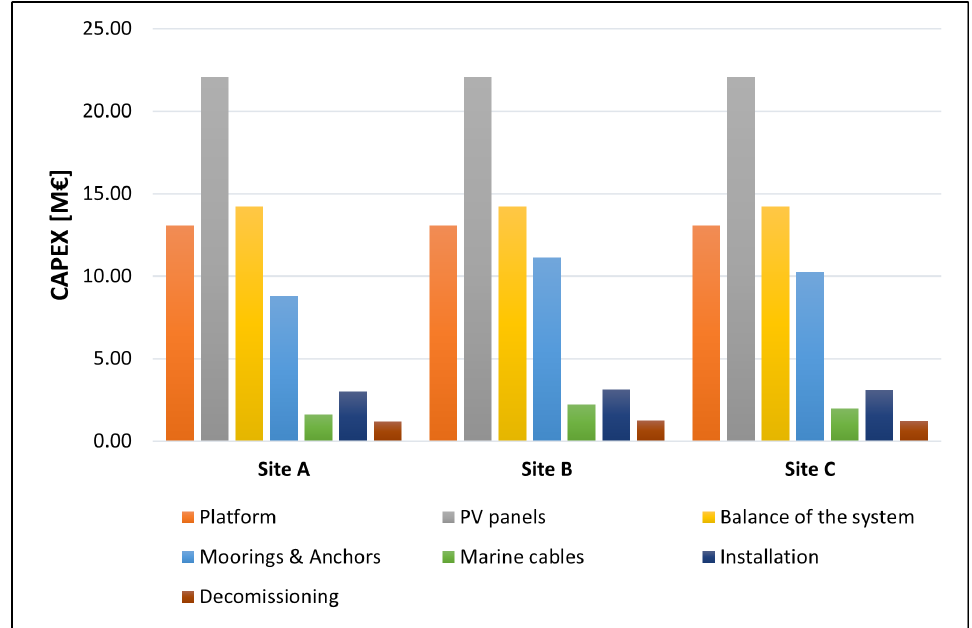
Figure 16. Capex main items for the three considered sites.